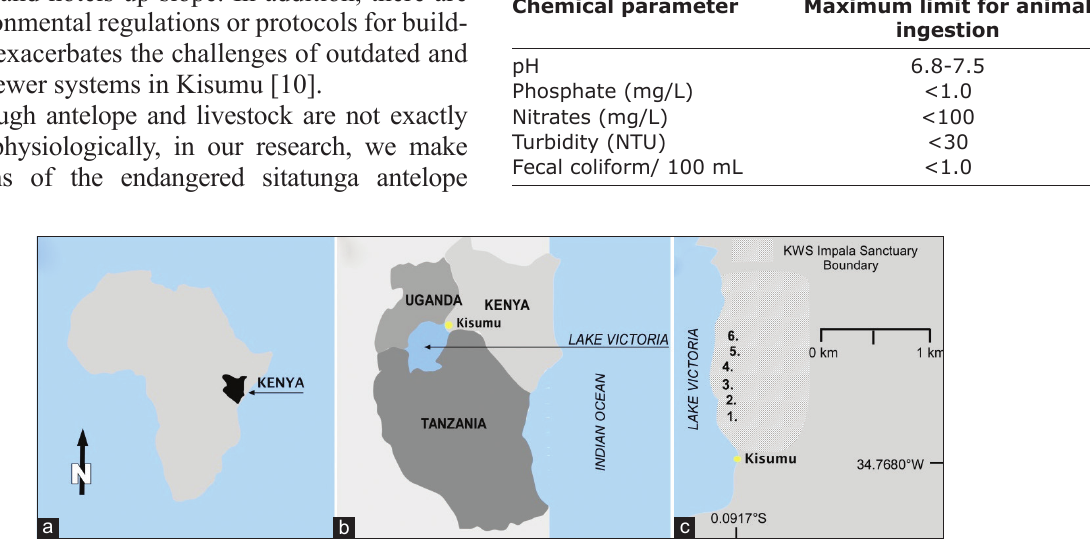
Table-1: Maximum limit for animal ingestion from water (Agricultural Waste Management Field Handbook, 1992). Chemical